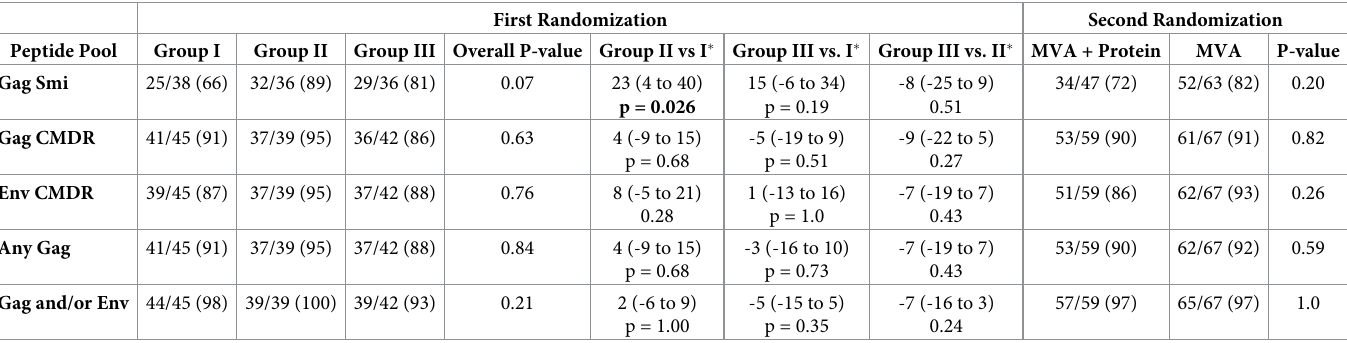
Table 2. Frequency of ELISpot Responses Two Weeks after the 2 nd MVA Alone or MVA Plus rgp140/GLA-AF Vaccination by First (Group I: 2x 0.1 mL ID [3mg/ mL], Group II: 2x 0.1 mL ID + Electroporation [3mg/mL], Group III: 1x 0.1 mL ID + Electroporation [6mg/mL]) and Second (MVA Plus rgp140/GLA-AF or MVA Alone)